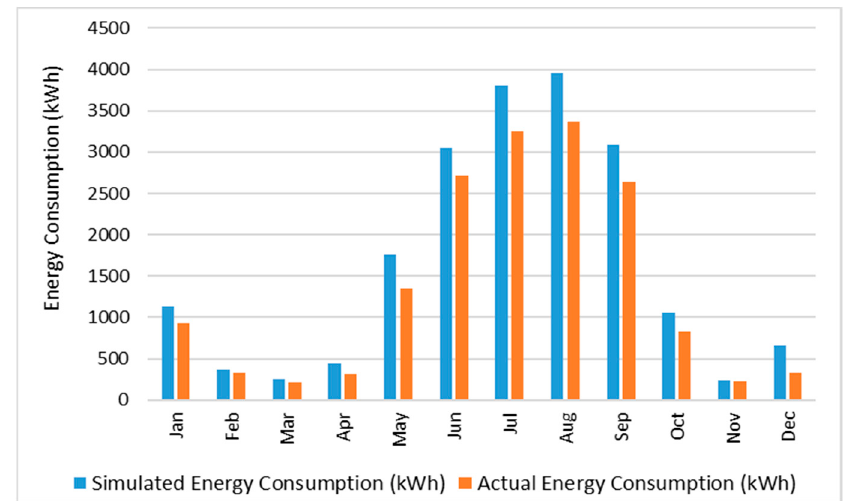
Figure 4. Total energy consumption comparison.